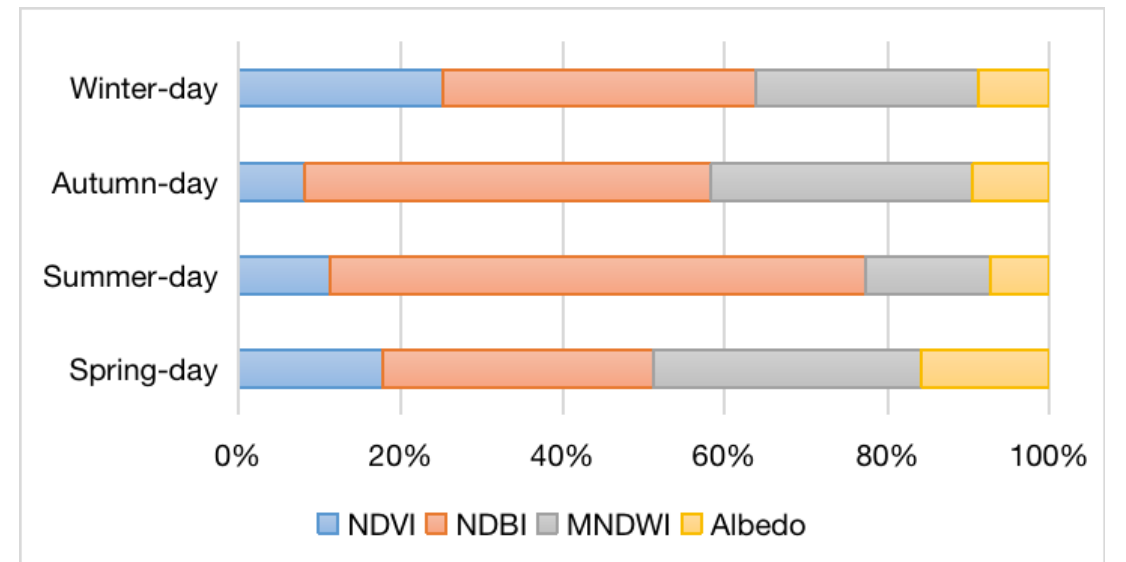
Figure 11. Comparison of the contributions of land cover indices regarding the LST by standardized regression coefficients.